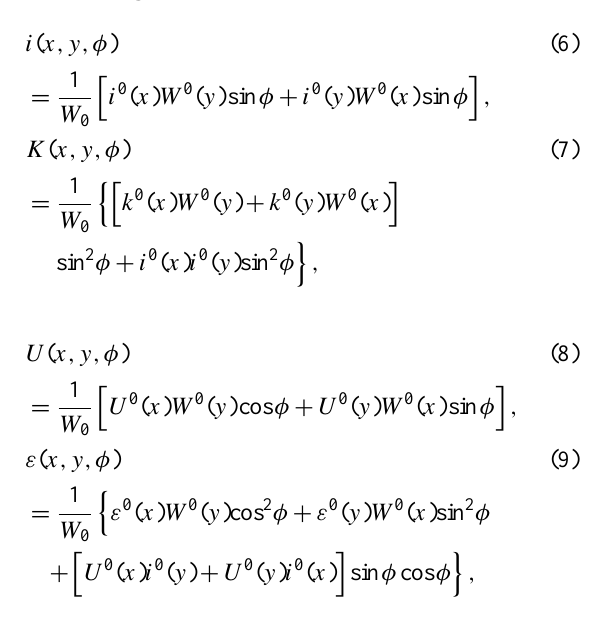
1. W ( x,y ) is the subsidence value of any surface point ( x